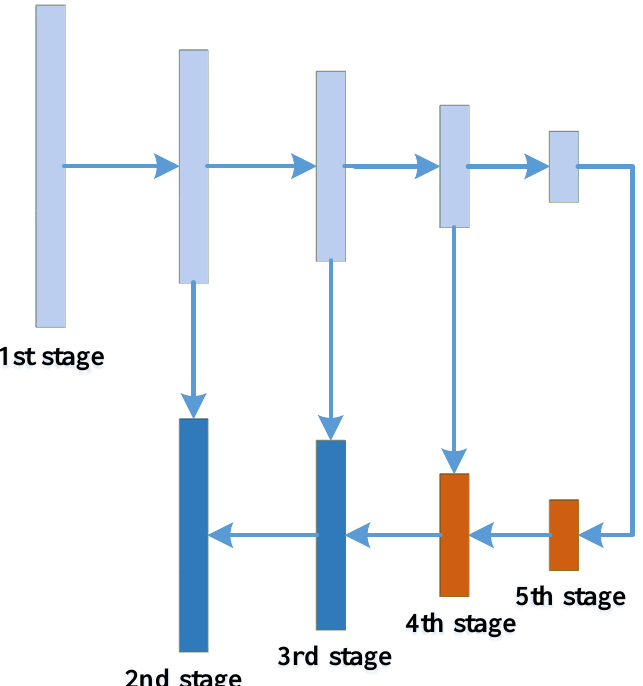
Figure 2. The architecture of the feature pyramid network